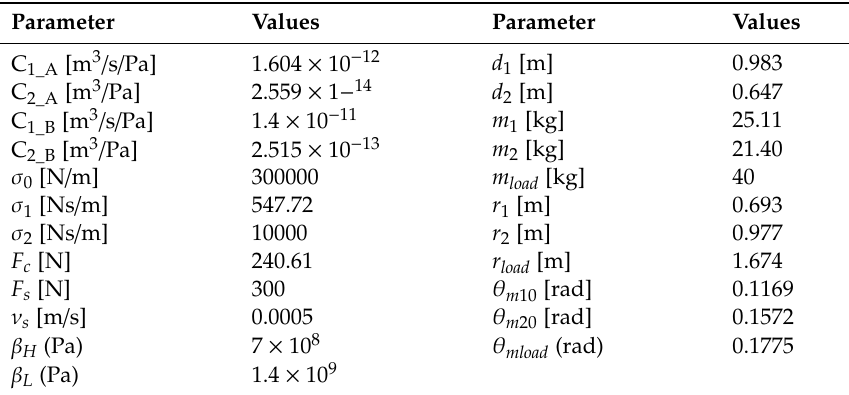
Figure 4. Electric motor rotational speed measured by the encoder. Table 2. Pump/motor parameters.